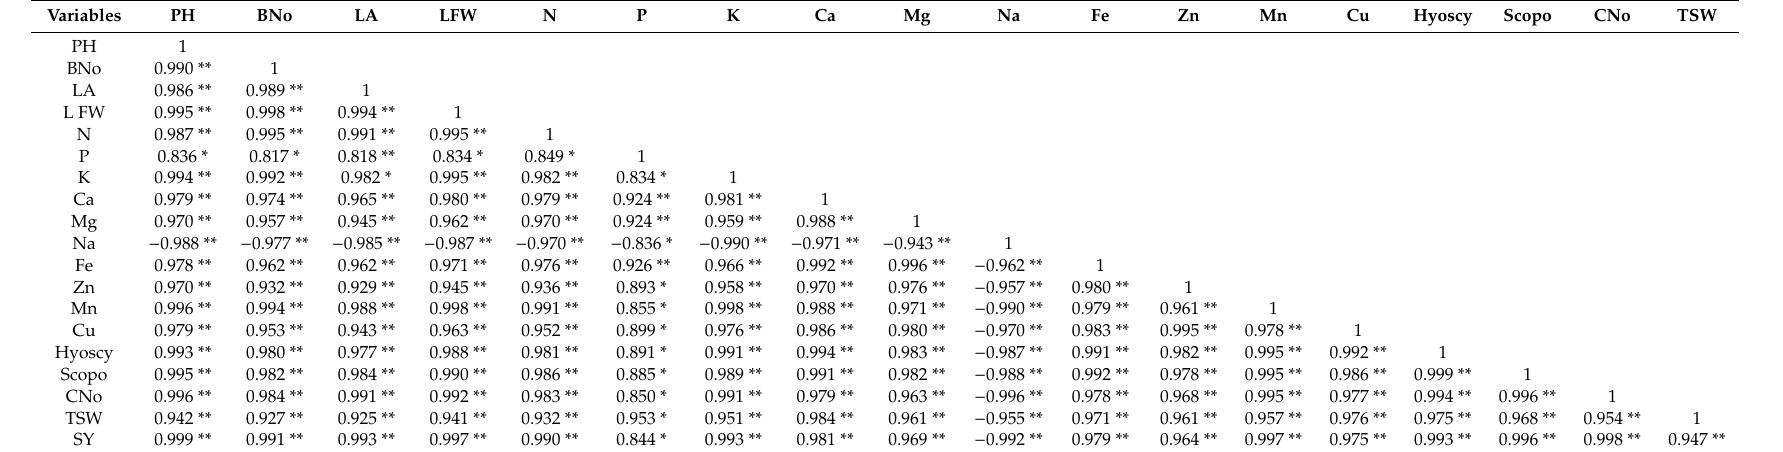
Table 7. Pearson’s correlation coe ffi cients (below diagonal) among all studied attributes of Egyptian henbane grown with three mineral nitrogen fertilizer doses and Rhizobacterein